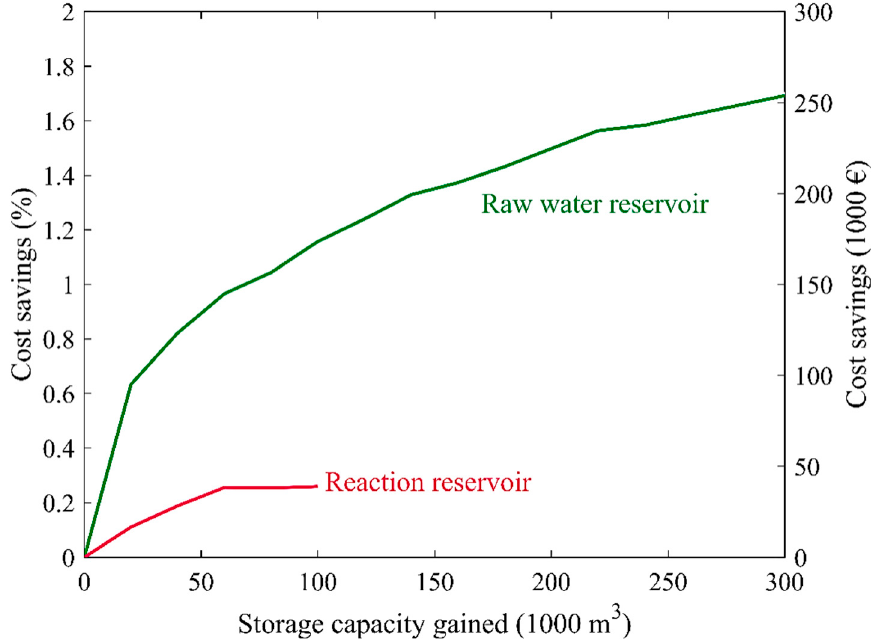
Figure 4. Cost saving potential for different storage options with varying additional storage capacity.